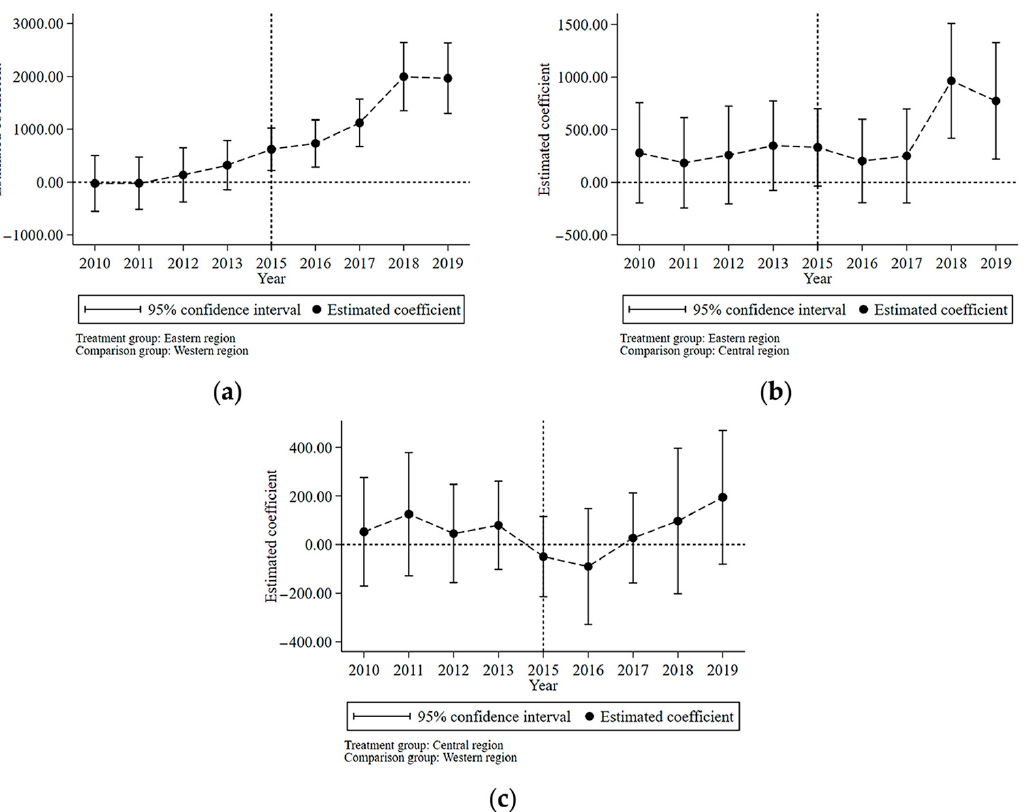
Figure 2. Parallel trend test of Model Ⅰ . ( a ) Parallel trend test between cities in the eastern and western regions; ( b ) Parallel trend test between cities in the eastern and central regions; ( c ) Parallel trend test between cities in the central and western regions.